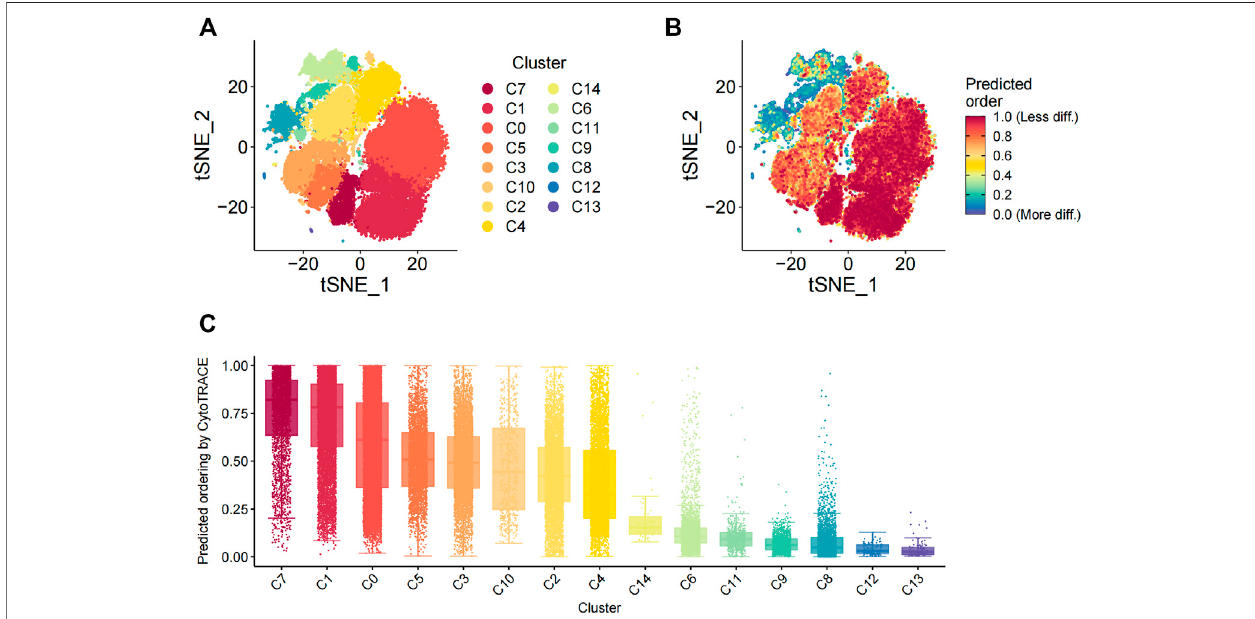
FIGURE 3 | Evaluation of the differentiation status of cells in the 15 cellular subsets. (A) TSNE_plot shows the distribution of the 15 different cell subsets with differentcolorcodesinthelow-dimensionalspace. (B) TSNEplotshowsthedistributionofthe15differentcellsubsetsbasedonthedegreeofdifferentiation.Thedegree of differentiation is denoted by the color code, with red representing low differentiation status and blue denoting high differentiation status. (C) The box plot shows the differentiation status of all cells in the 15 different cell subsets. The cells are ordered from low to high degrees of